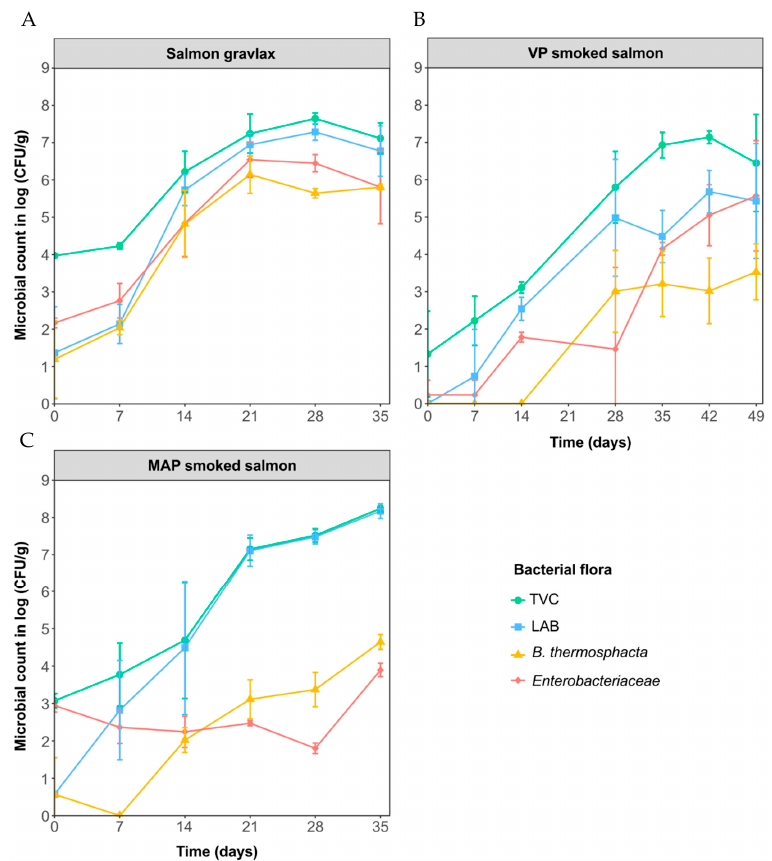
Figure 1. Microbial kinetics in the salmon gravlax (SG) (A), cold-smoked salmon packed under vacuum (VP CSS) (B) and cold-smoked salmon packed under modified atmosphere (MAP CSS) (C)during storage at 4 °C for 1 week and then at 8 °C. Bars represent the standard deviation of the mean of 3 replicates.